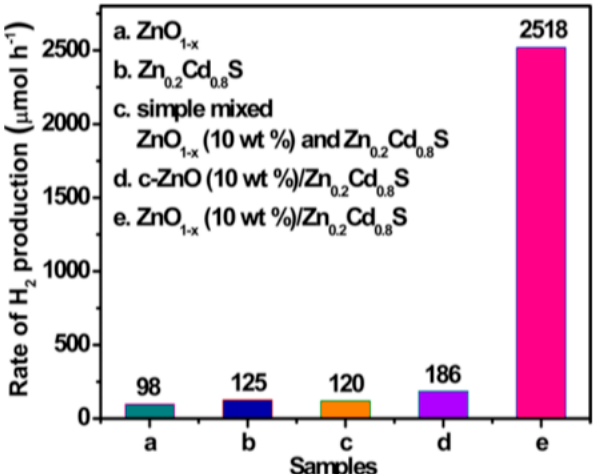
Figure 17. Photocatalytic hydrogen evolution rate of (a) oxygen-vacant ZnO 1 − x nanorods, (b) Zn 0.2 Cd 0.8 S nanoparticles, (c) mechanical mixture of ZnO 1 − x and Zn 0.2 Cd 0.8 S, (d) commercial oxygen-vacancy-free ZnO coupled with Zn 0.2 Cd 0.8 S and (e) ZnO 1 − x (10 wt %)/ Zn 0.2 Cd 0.8 S Z-scheme catalyst with a heterojunction [61]. Reprinted with permission from ref. [61].